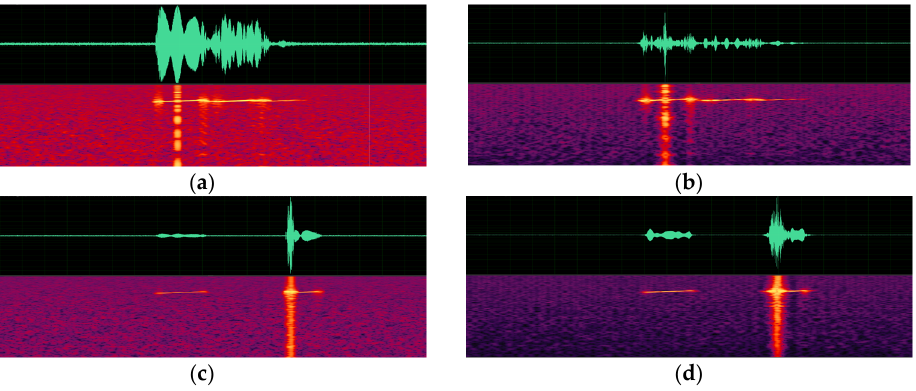
Figure 9. Spectrograms of active sonar signals with various depth parameters. ( a ) Original signal with a depth of 180 m. ( b ) A synthesized signal with a depth of 180 m. ( c ) An original signal with a depth of 660 m. ( d ) A synthesized signal with a depth of 660 m.